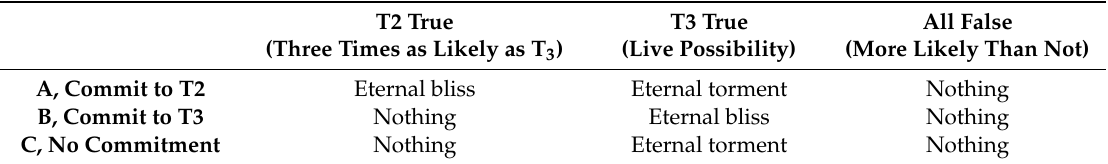
Table 3. Supernatural bads as a live